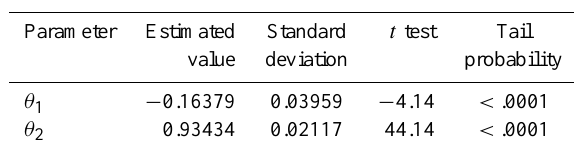
Table 1. Estimated parameters of the conventional seasonal ARMA